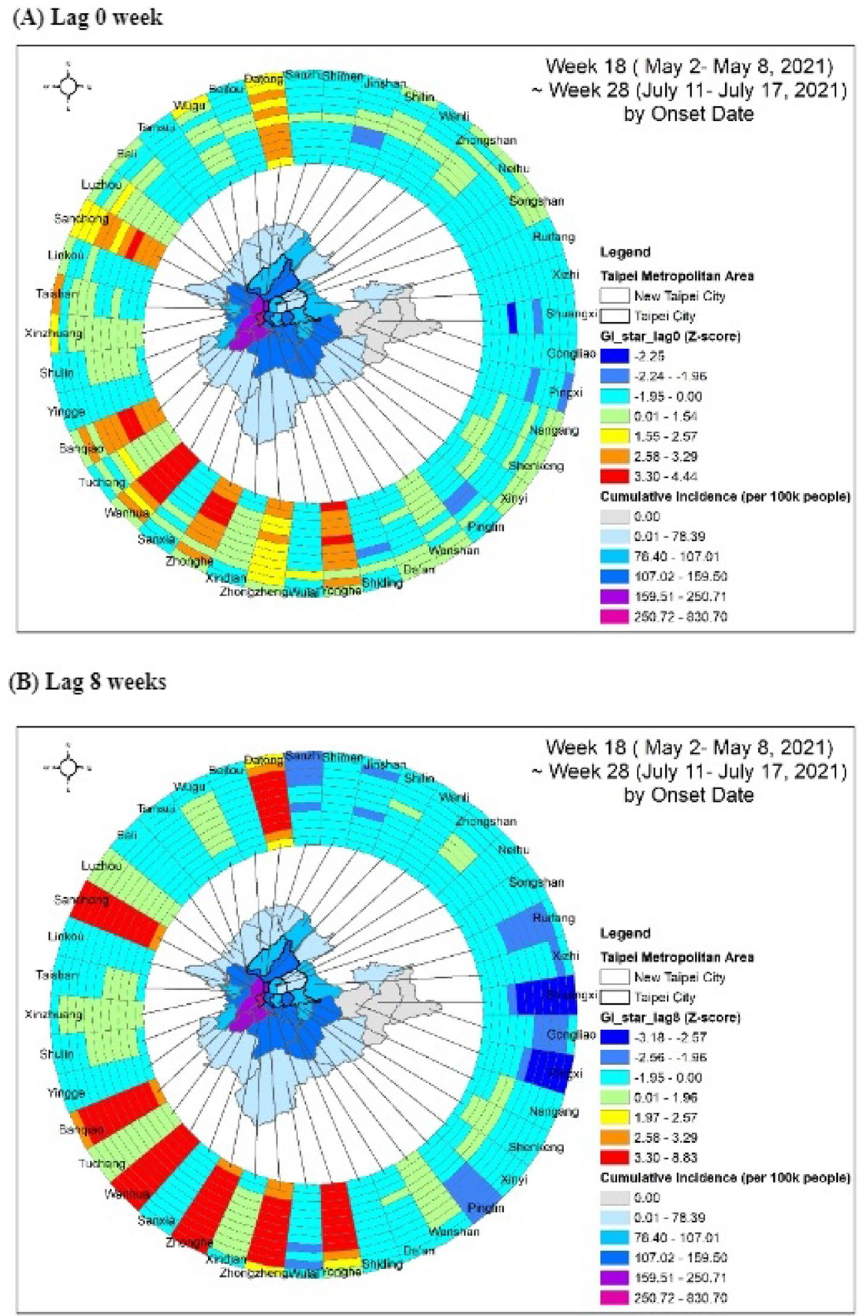
Figure 4. Spatiotemporal hotspot detection of COVID-19 incidence at the district level in Taipei and New Taipei City. The map was created by ArcGIS (ArcMap, version10.3; ESRI Inc., Redlands, CA, USA) and the ring map was created by the ring map toolbox in ArcGIS (https:// www. esri. com/ about/ newsr oom/ arcus er/ looki ng- at- tempo ral- chang